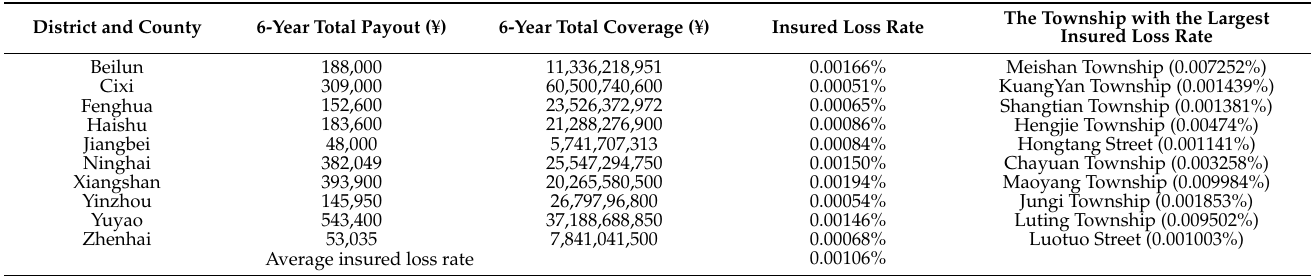
Figure 8. Insured loss rate of townships due to type III typhoons. ( a ) 1616 Malakas; ( b ) 1618 Chaba; ( c ) 1718 Talim. Table 2. Summary of insurance claims for rural housing in the Ningbo districts and counties caused by